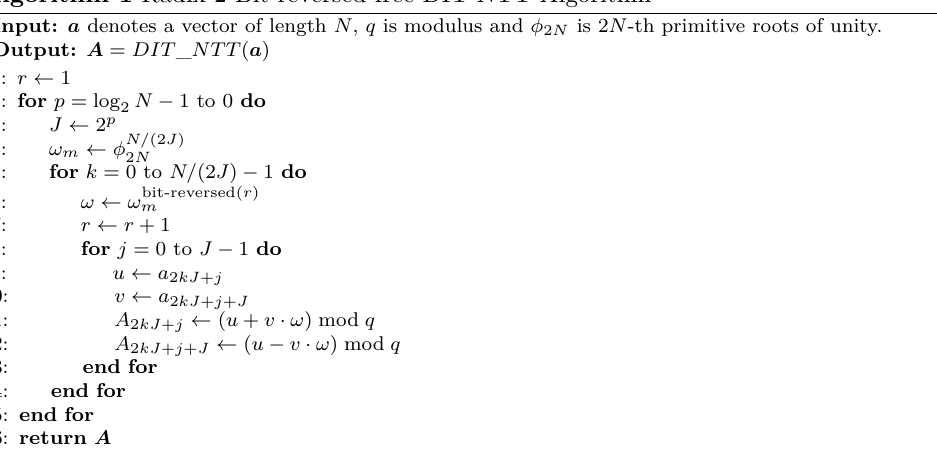
Algorithm 1 Radix-2 Bit-reversed-free DIT NTT